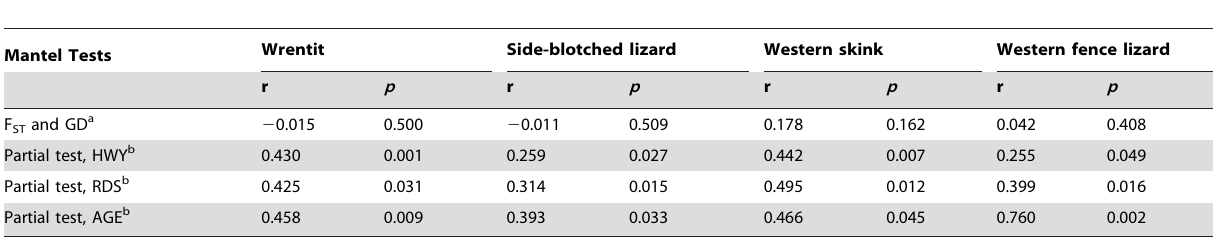
a Mantel test correlations between genetic distance (F ST ) and geographic distance (GD). b Partial Mantel tests for partial correlations between the presence of Highway 23 only (HWY), the presence of major roads including Highway 23 (RDS), and the age of isolation between patches (patch age; AGE) while controlling for geographic distance.